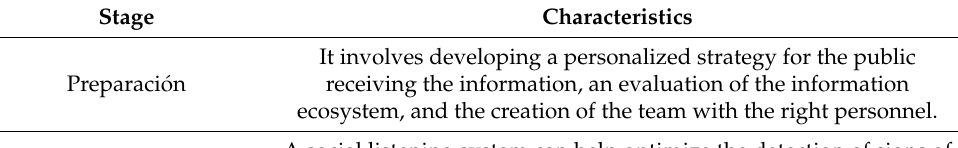
Table 2. Stages of intervention for management to combat misinformation. Stage Characteristics Preparaci ó